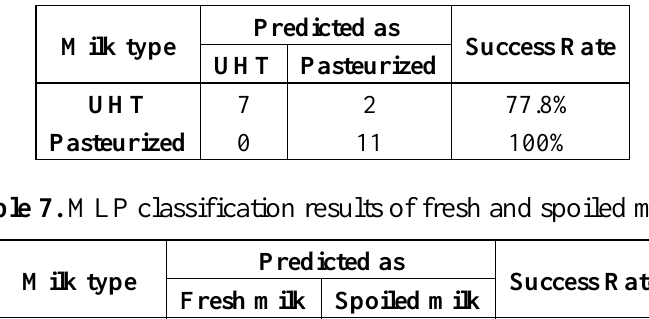
Table 6. MLP classification results of UHT and pasteurized milks.